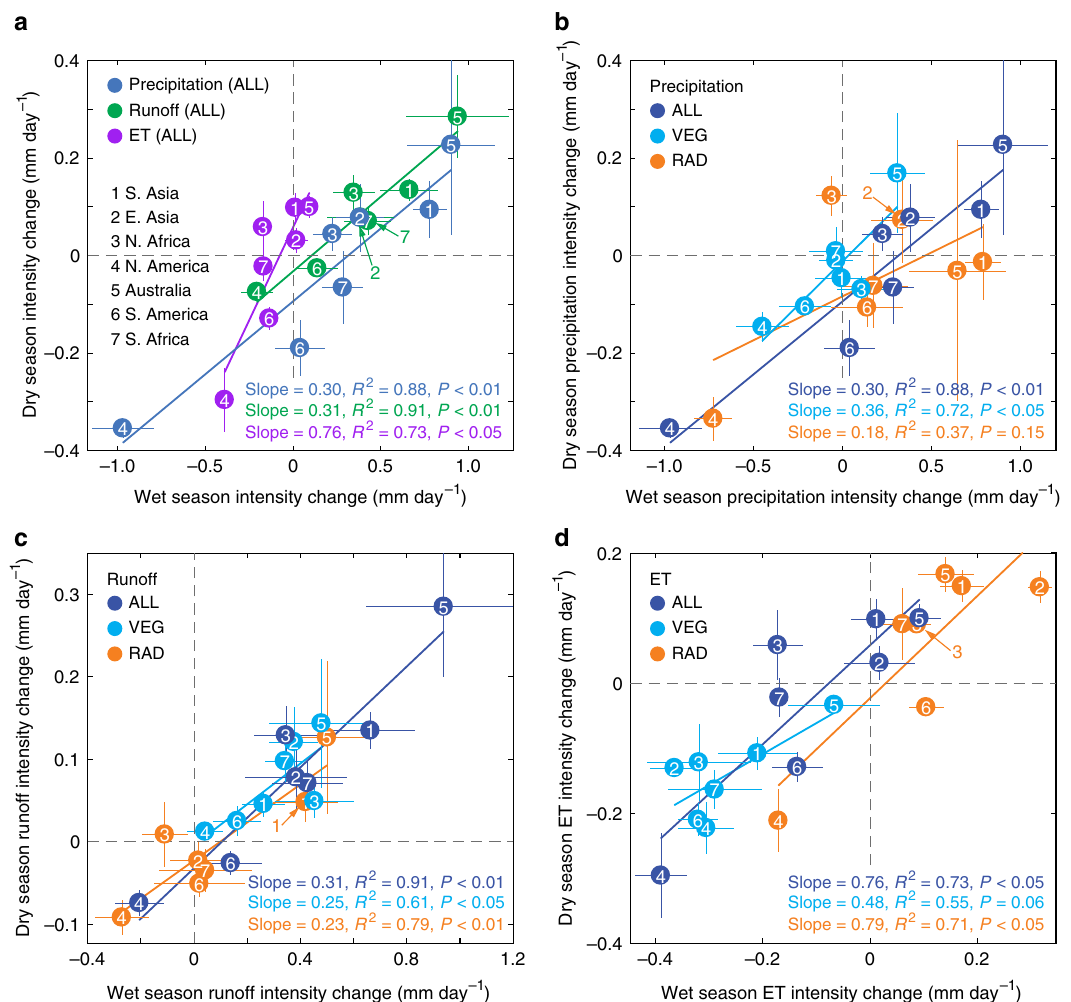
Fig. 2 Intensity changes in precipitation, runoff and evapotranspiration (ET) and their drivers in wet and dry seasons. a Intensity change in precipitation, runoff and ET in wet (horizontal axis) and dry seasons (vertical axis) in all CO 2 -based forcings (ALL) simulations. Regions labelled as 1 – 7. Any overlapping circles are pointed to by labels connected by an arrow. The colour lines indicate the linear regressions between water cycle component changes in wet and dry seasons across the seven monsoon regions, with the slope value and statistical information shown in the bottom right. b – d Intensity changes in ALL simulations are further divided into physiological (RAD) and radiative (VEG) drivers in wet and dry seasons for b Precipitation, c Runoff, and d ET. Intensity changes are quanti fi ed by the differences of the years 121 – 140 (approximately atmospheric enrichment of 4 × CO 2 of preindustrial levels) of simulations and the years 1 – 20 (historical) in the wet or dry seasons. The wet season is de fi ned as the months where ET < precipitation, and vice versa for the dry season. Wet and dry season lengths are kept constant and correspond to those for the historical period and for each monsoon region. This approach allows changes in average seasonal intensity to be isolated from changes in season length (see Methods section). The thin lines are error bars, indicating the standard errors of the mean of the four